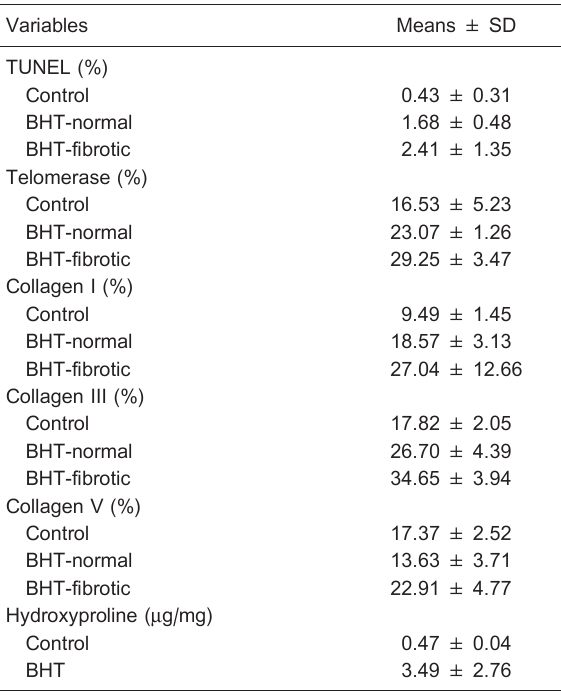
Table 1. Summary of histomorphometric